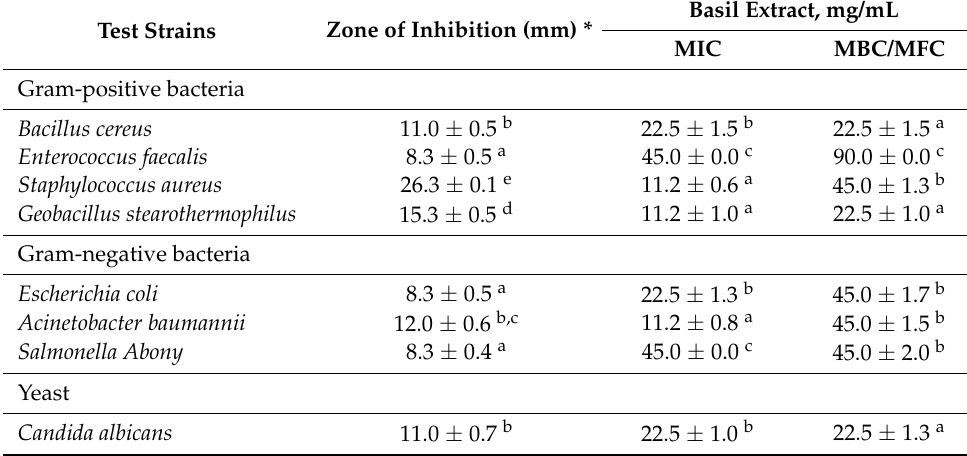
Table 2. Antimicrobial activity of the basil extract against bacteria and yeast